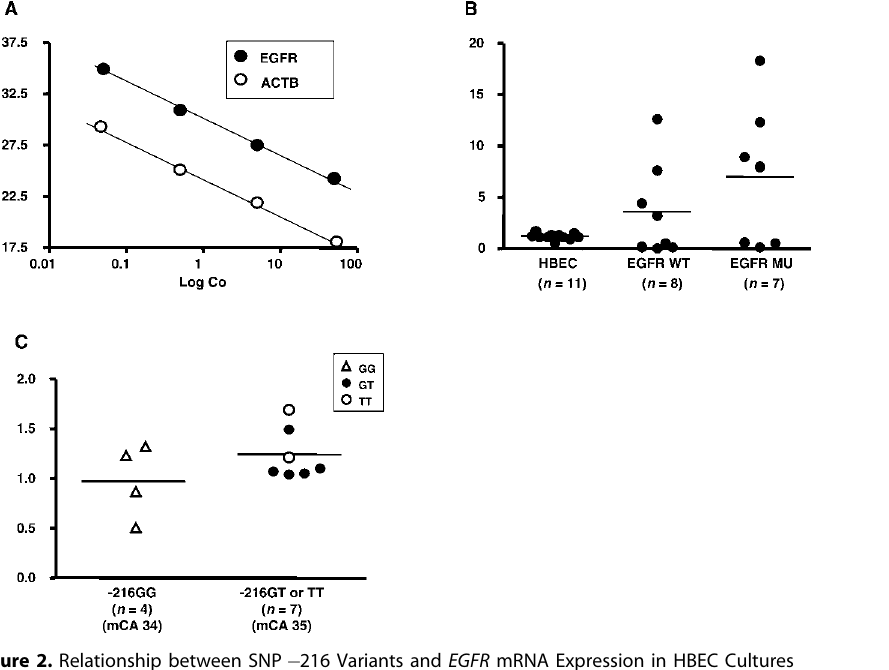
Figure 2. Relationship between SNP (cid:2) 216 Variants and EGFR mRNA Expression in HBEC Cultures (A) Standard curves of EGFR and ACTB . Both slopes of cycle threshold (Ct)/log copies (Log Co) were mostly coincidental. (B) Comparison of relative ratio of EGFR/ACTB among three groups of cultured cells (HBECs, lung cancer cell lines without EGFR mutations [WT], and lung cancer cell lines with EGFR mutations [MU]). (C) Comparison of relative ratio of HBECs having SNP (cid:2) 216 G/G versus G/T or T/T. mCA, mean number of CA-SSR1 repeats.